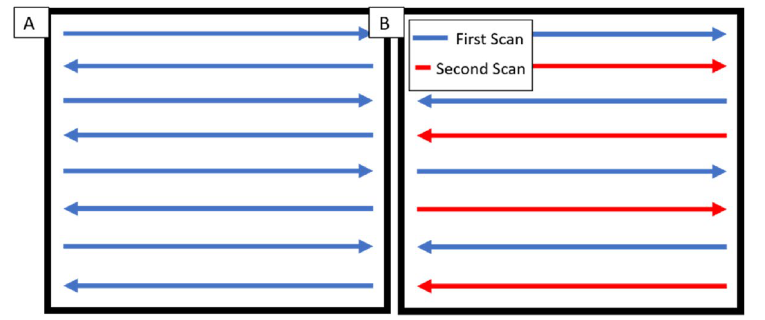
Figure 2. Comparison of ( A ) Conventional Raster and ( B ) Skip raster techniques.